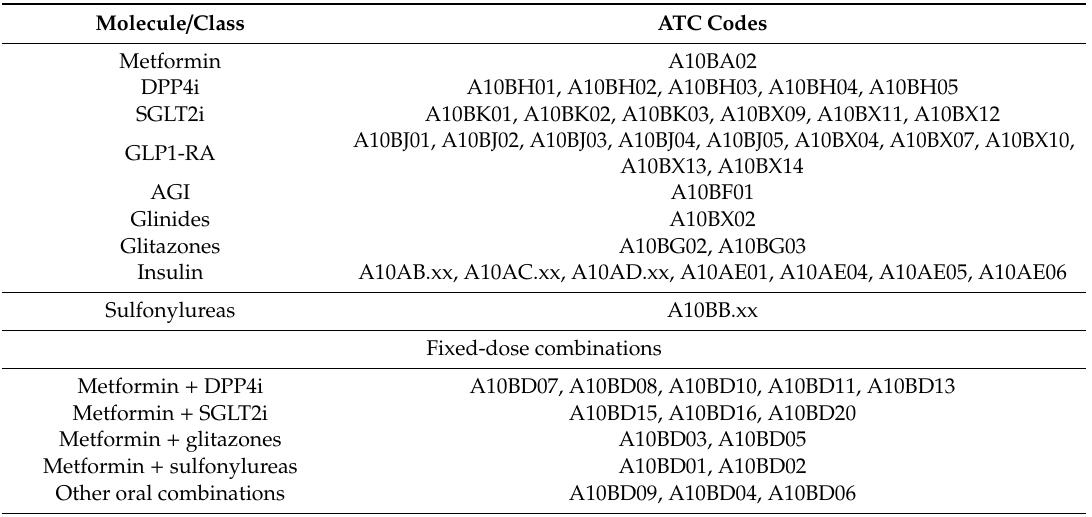
Table A1. List of study